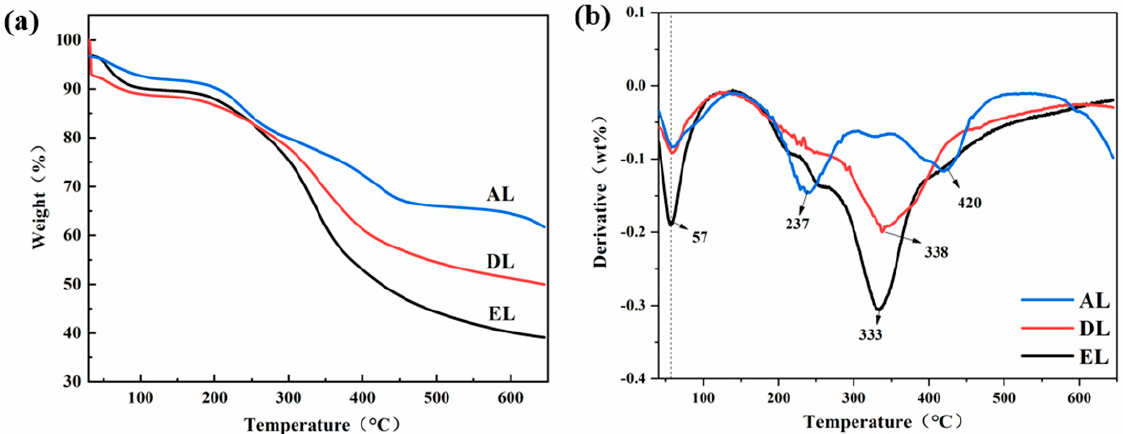
Figure 3. Thermal performance analysis of different kinds of lignin: ( a ) TG curve; ( b ) DTG curve.